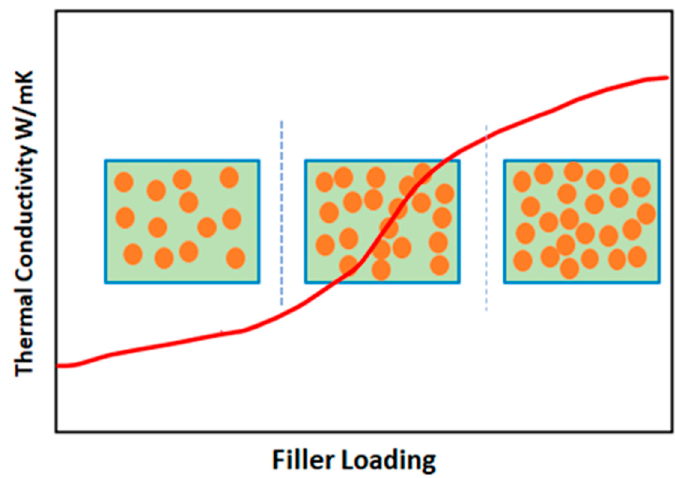
Figure 3. Schematic illustration of the percolation phenomenon.